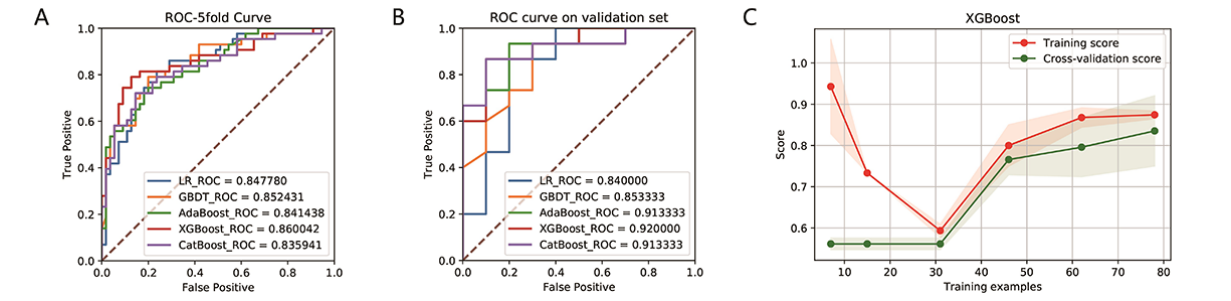
Figure 5. ROC curves showing the fitting performance (A) and prediction performance (B) of the LR, CatBoost, GBDT, XGBoost, and AdaBoost prediction models based on the eight important features in the training data set and the test data set. (C) The learning curve on the training set showing the learning process of the XGBoost model. The red line is the fitting effect of the model on the overall training set, and the green line is the fitting effect of the model on the training set with 5-fold cross-validation. The two curves finally merge near 0.85, indicating that the model is well fitted for training. AdaBoost: adaptive boosting; GBDT: gradient boosting decision tree; LR: logistic regression; ROC: receiver operating characteristic; XGBoost: eXtreme Gradient Boosting.